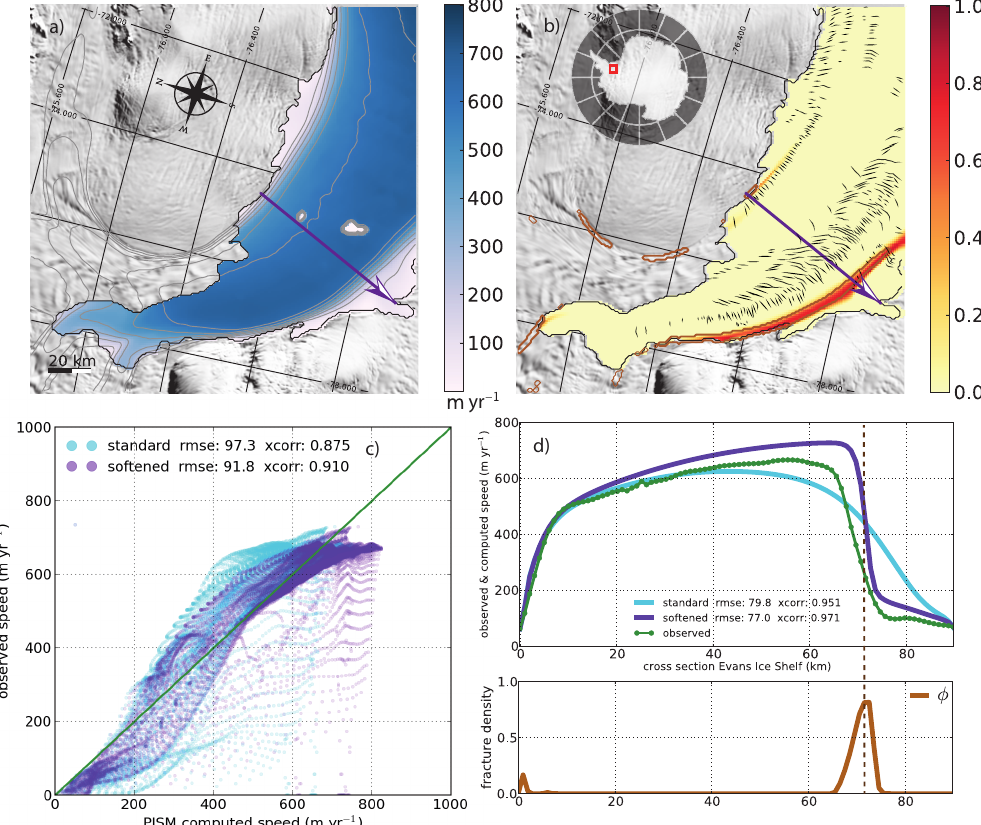
Fig. 9. Observed surface speed (a) and calculated fracture density (b) in the Evans inlet in western Ronne Ice Shelf (green box in Fig. 6b). In the lower panels values of observed (green dots) and calculated ice speed are presented, light blue for the constant flow enhancement, violet for fracture-induced softening. Corresponding fracture density (brown) is plotted along the indicated cross section. Parameters: FESOM- melting factor 1.0, E SSA = 0 . 05, γ = 0 . 2, σ cr = 140kPa, γ h = 0 . 1, ˙ (cid:15) h = 12 × 10 − 10 s − 1